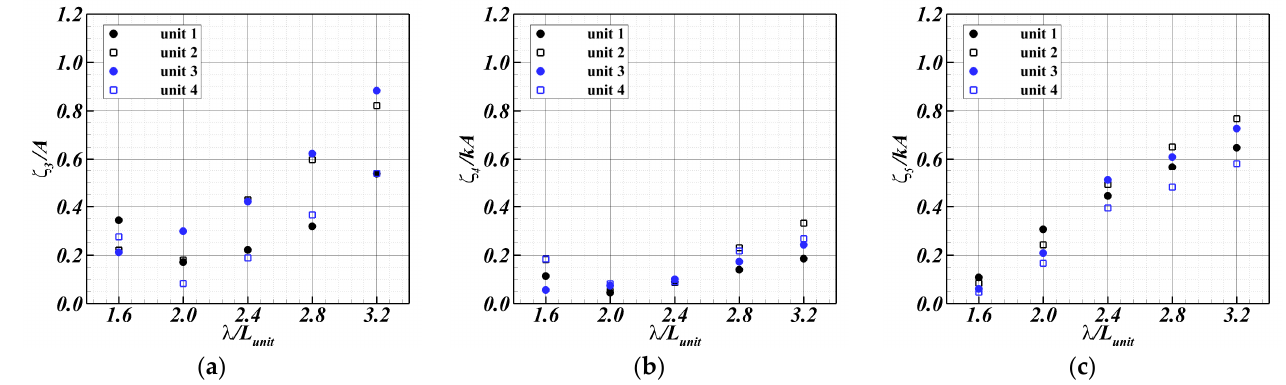
Figure 25. Motion RAOs of the experiement according to wavelength under oblique sea: ( a ) heave; ( b ) roll; ( c ) pitch.